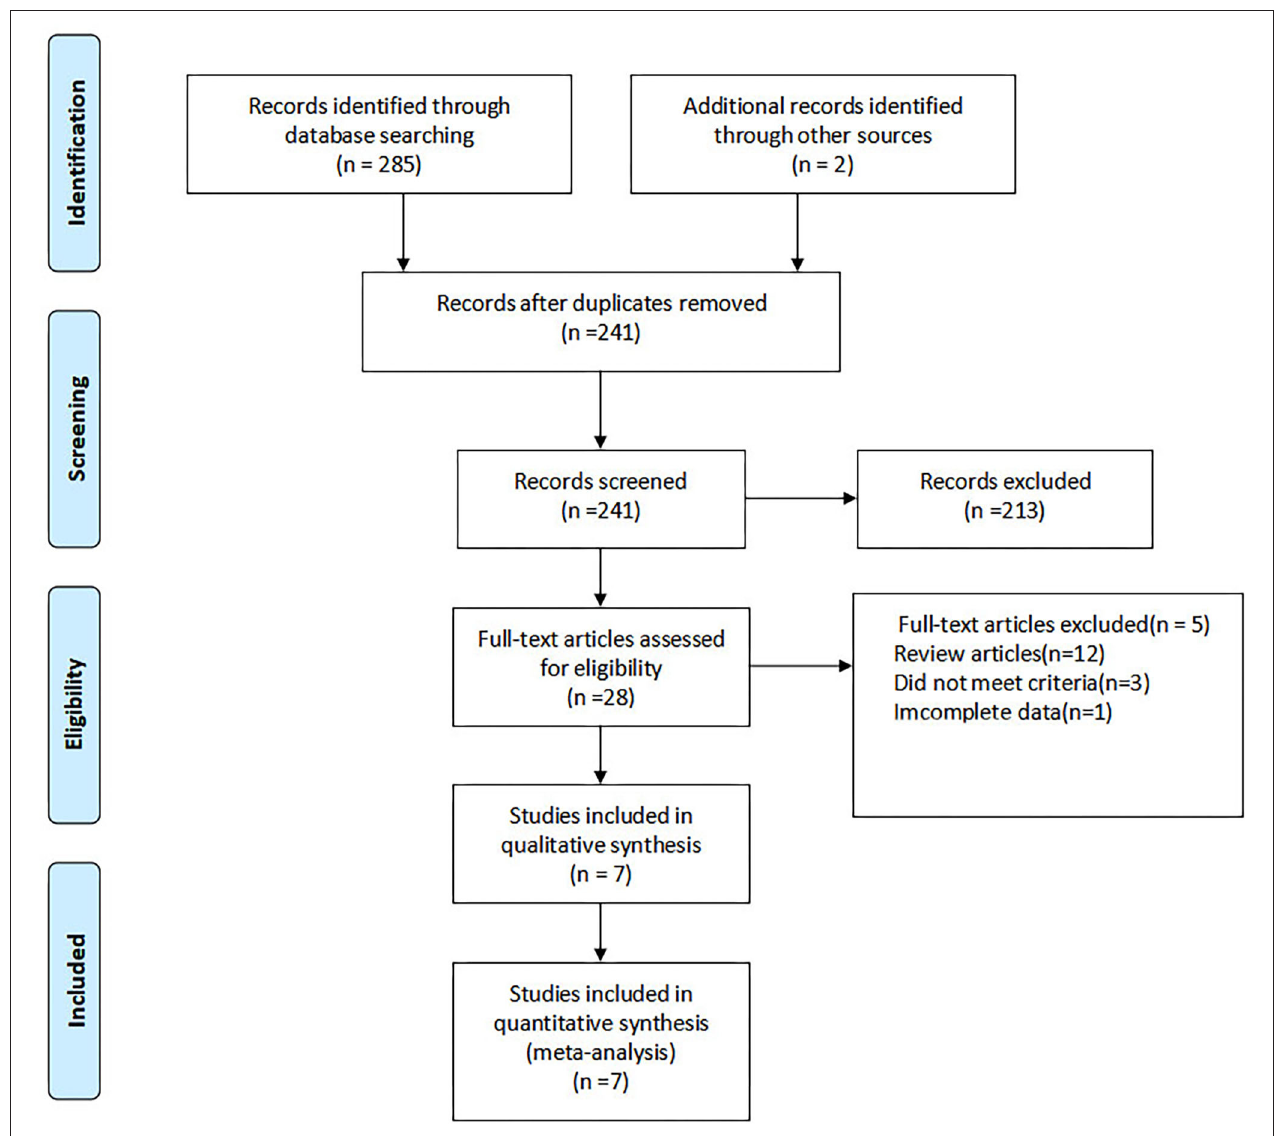
FIGURE 1 | Flow diagram of studies selection